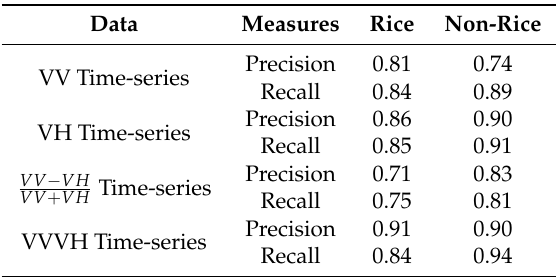
Table 5. Precision and recall for rice classification over four feature datasets.